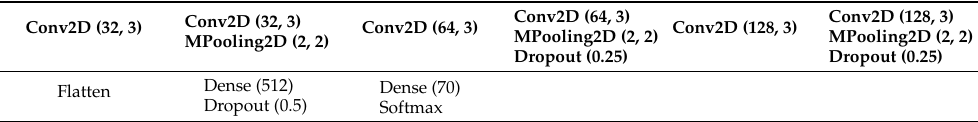
Table 1. Detailed configurations of the convolutional neural network. Read from left to right, top to bottom. Conv2D (32,